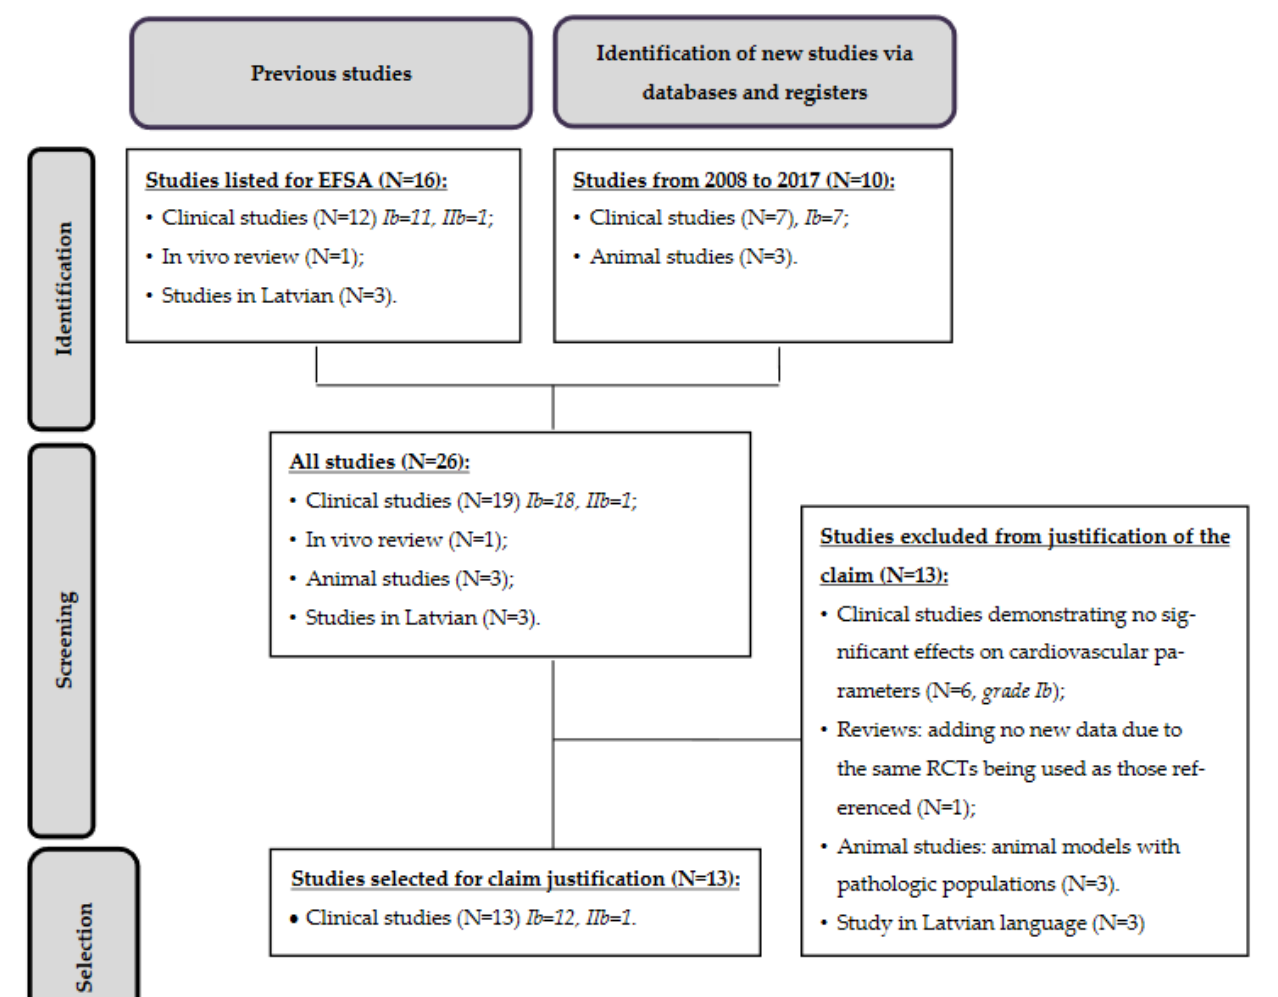
Figure 2. Flow diagram of study selection regarding the pending claim.